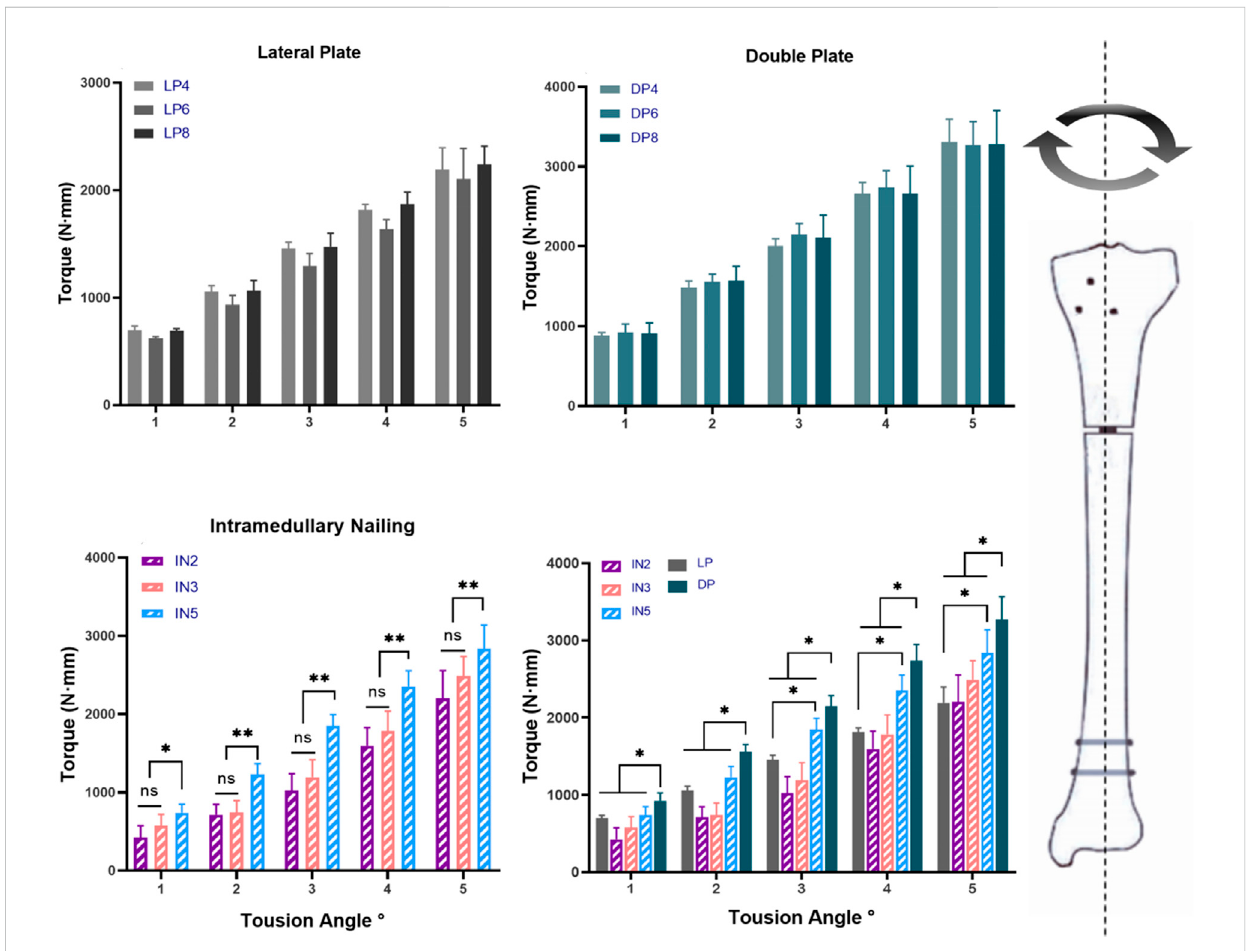
FIGURE 6 Torque and the torsion angle relationship of different models: lateral plate fi xation groups (LP), double plate fi xation groups (DP), intramedullary nailing groups (IN) and multiple comparisons. (ns, no signi fi cant difference; * p < 0.05; ** p < 0.01).